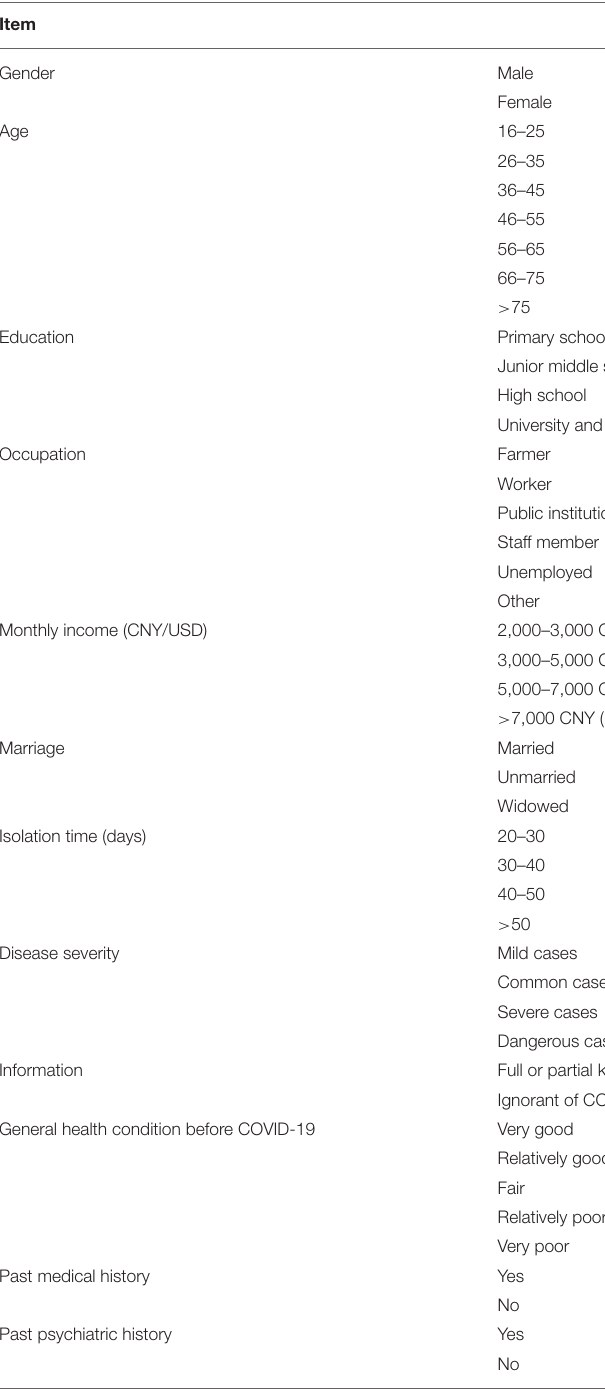
TABLE 1 | Demographic characteristics and other information of patients ( N =